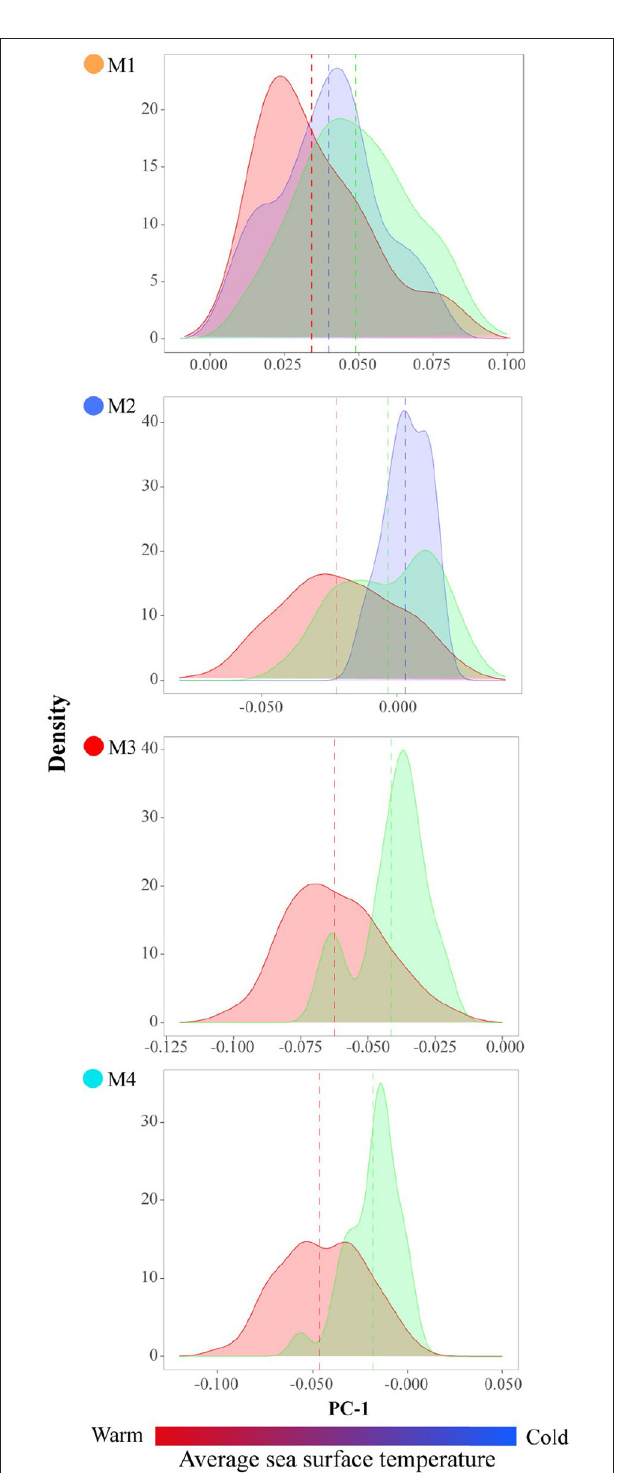
FIGURE 4 | Variation of each phenotype of the Trachurus picturatus off the north and central eastern Atlantic Ocean by region: the Canary Islands (red), Madeira (green), and mainland Portugal (blue). For the phenotypes M1 and M3, mainland Portugal is not represented due to lack of enough data ( n < 10). This graph aims to show that each phenotype changes in each region, probably due to environmental conditions such as temperature.